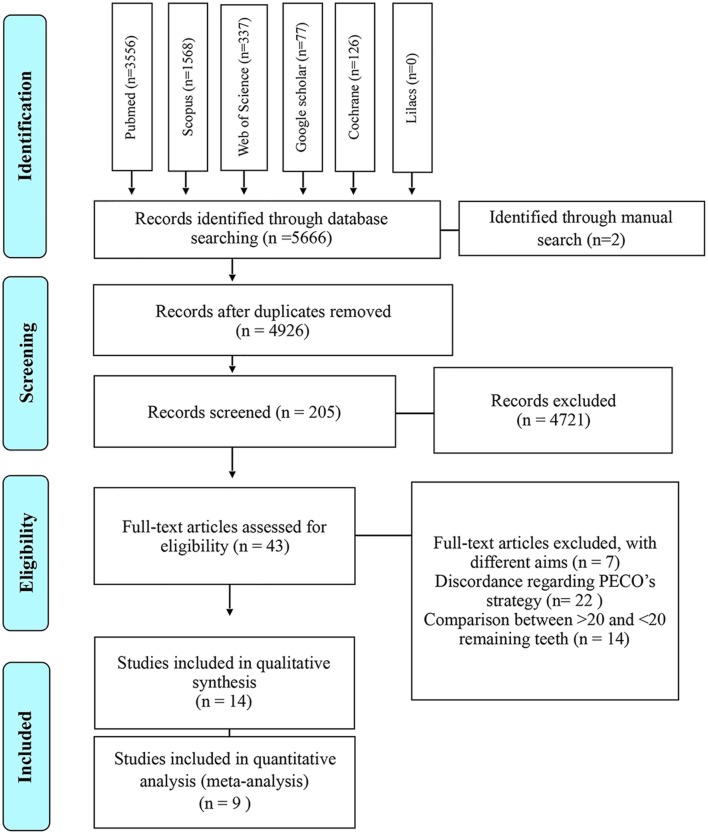
Flow diagram for study selection according with PRISMA statement.